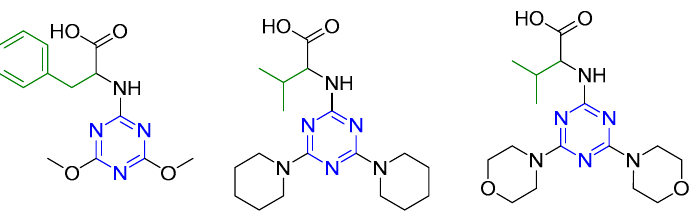
Figure 3. Potential compounds as inhibitors of monoamine oxidase A and B (MAO-A and B).